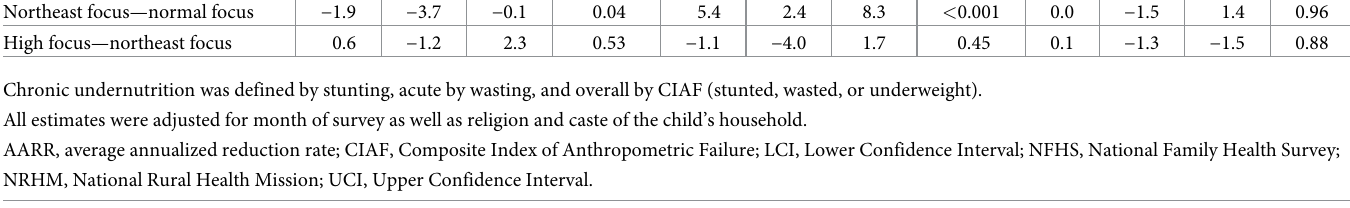
Table 2. Differences of the differences between focus states groups for AARR changes in the post-NRHM (2005 to 2015) versus pre-NRHM periods (1992 to 2005) based on results from the Indian NFHS. Chronic Acute Overall Δ LCI